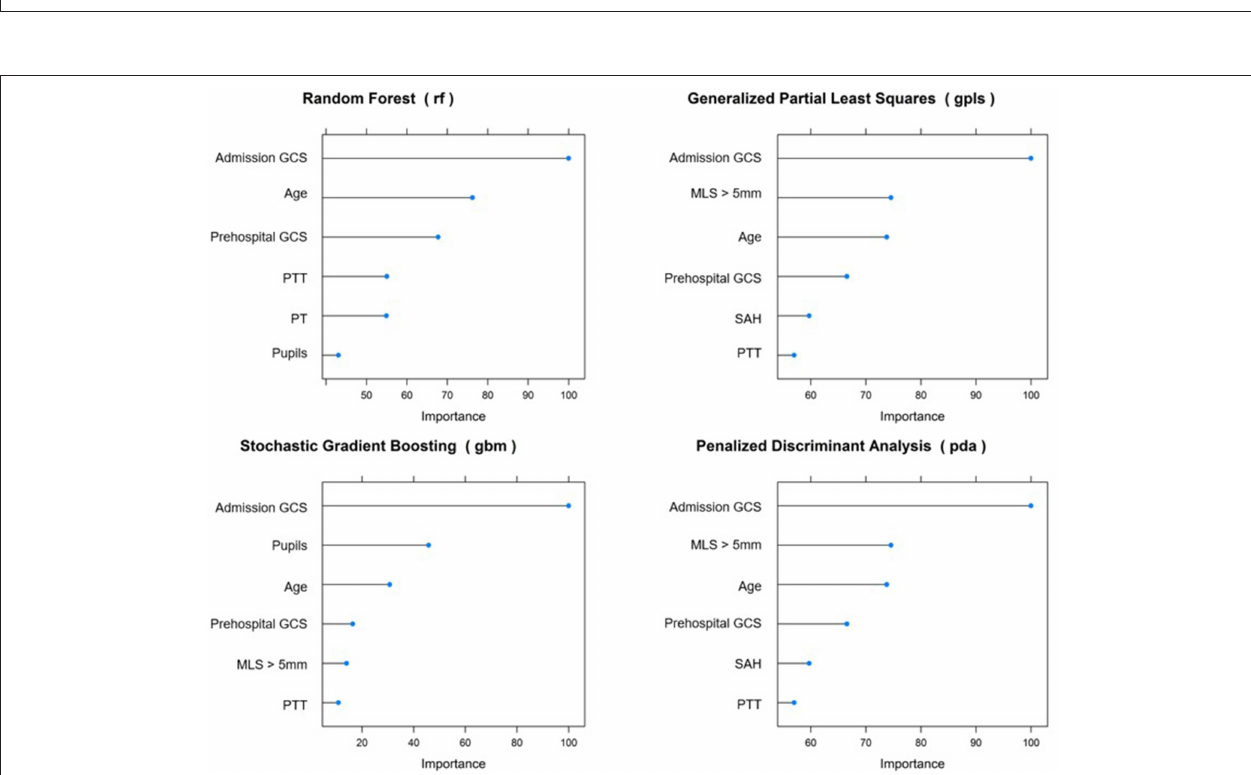
FIGURE 4 | Most important variables predicting in-hospital mortality. GCS, Glasgow Coma Score; MLS, midline shift; PTT, partial thromboplastin time; PT, prothrombin time.